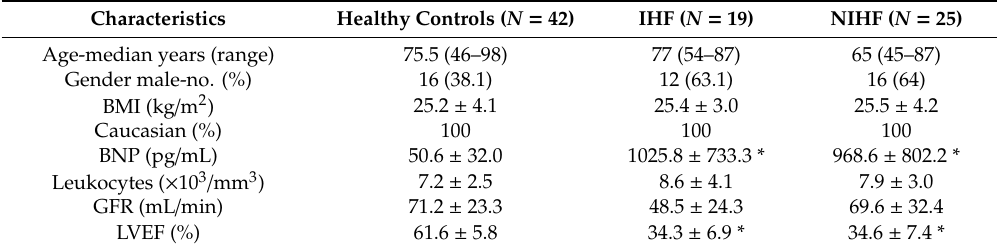
Table 1. Demographic and clinical characteristics of patients with ischemic heart failure (IHF) or non-ischemic heart failure (NIHF) and healthy